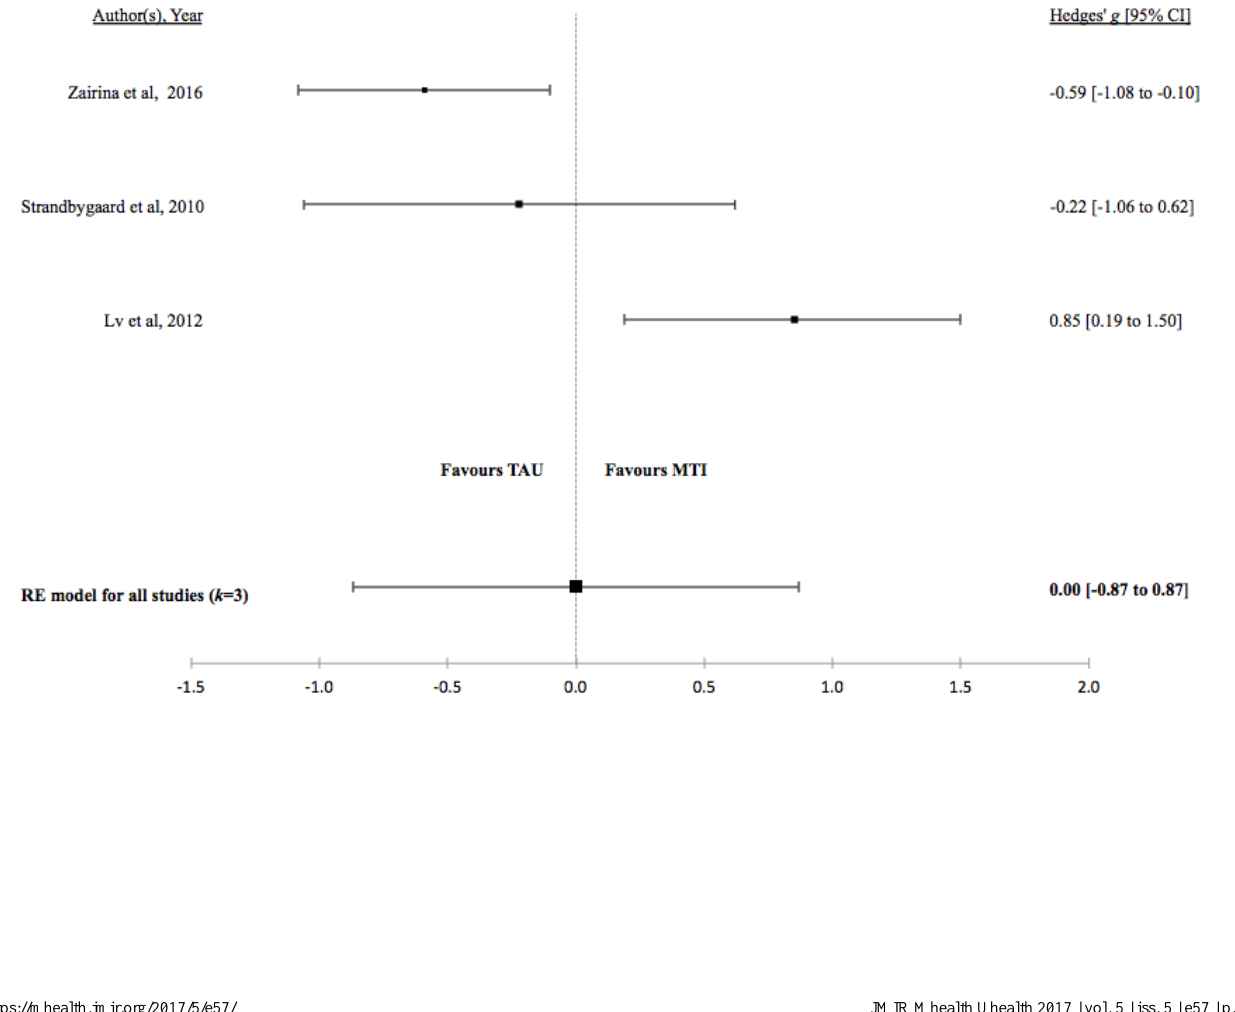
Figure 12. Forest plot of the standardized mean difference in asthma control between MTI and standard treatment. MTI: mobile technology